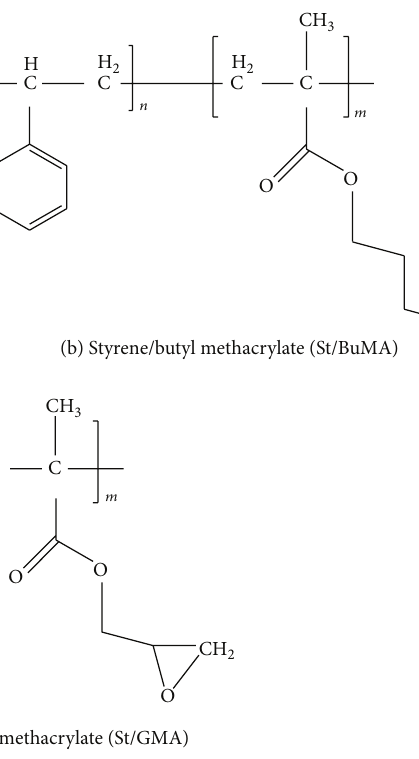
Scheme 1: The chemical structure of copolymer latexes.